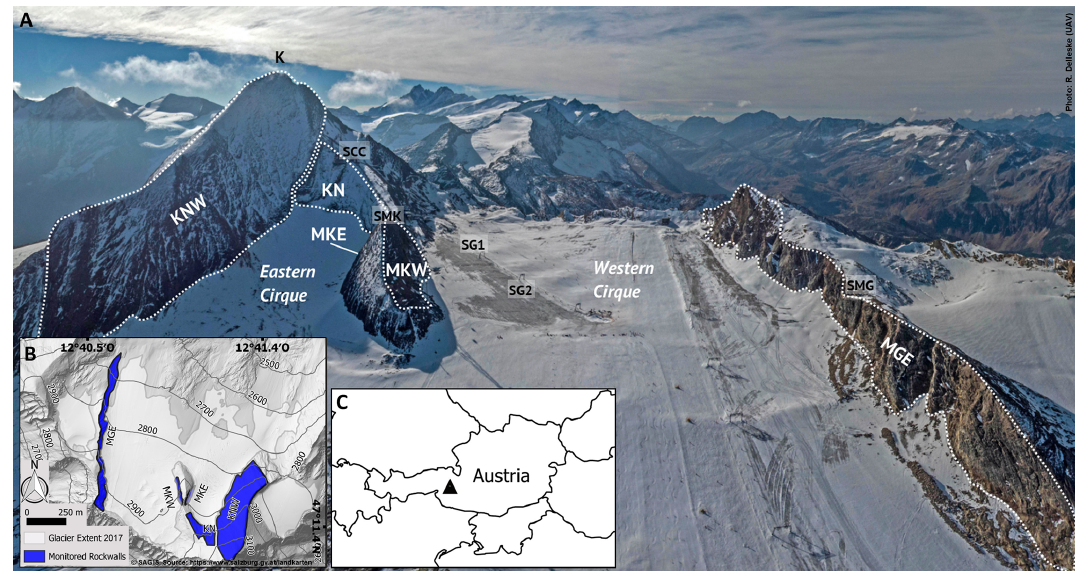
Figure 1. UAV view of rockwalls investigated (surface area, elevation above sea level, mean gradient are indicated in brackets): KN (23500m 2 ; 2920–3060ma.s.l.; 47 ◦ ), KNW (133400m 2 ; 2770–3200ma.s.l.; 44 ◦ ), MKE (11100m 2 ; 2850–2950ma.s.l.; 71 ◦ ), MKW (6300m 2 ; 2880–2940ma.s.l.; 63 ◦ ), MGE (60400m 2 ; 2740–2990ma.s.l.; 61 ◦ ) (photo: Robert Delleske). 1b: hillshade of study area with monitored rockwalls (blue) and glacier extent. 1c: location of study area within Austria. Abbreviations: K is Kitzsteinhorn (summit), SMK is scan position “Magnetkoepfl”, SCC is scan position “Cable Car Top Station”, SG1 is scan position “Glacier 1”, SG2 is scan position “Glacier 2”, and SMG is scan position “Maurergrat”; see text for further abbreviations.